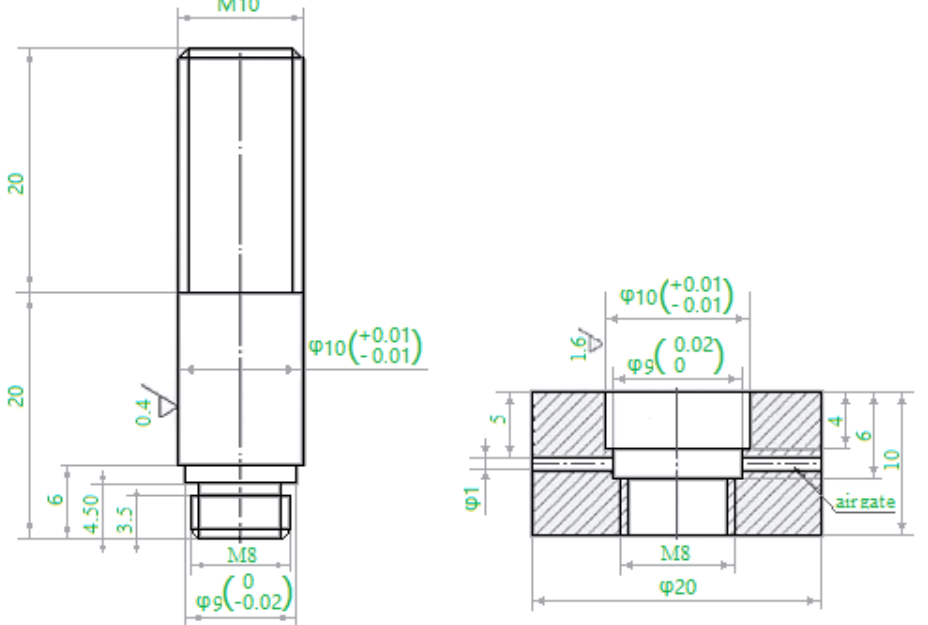
Figure 1. The brazed specimen for shear strength test (units: mm).